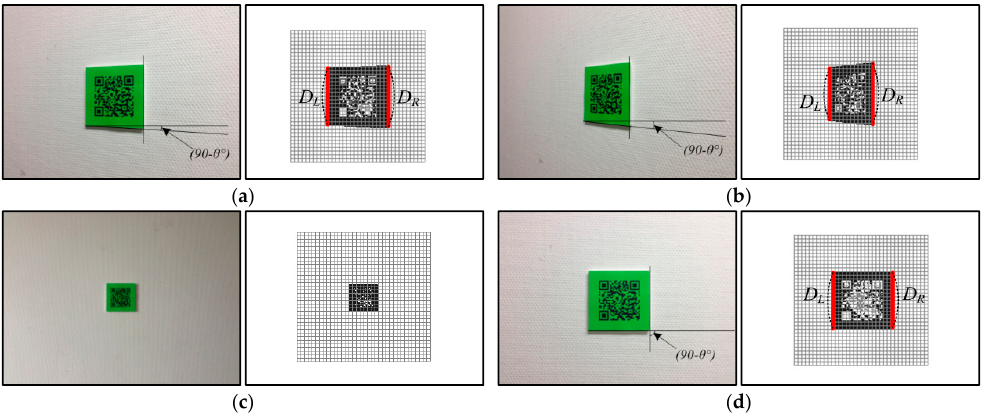
Figure 10. Process used to calculate the viewing angle from the camera to the color codes and the distance between them: ( a ) and ( b ) are images captured with the viewing angles of 20° and 50° at the distance of 0.5 m, respectively; ( c ) and ( d ) are images captured from the distance of 1.25 m and 0.5 m at the viewing angle of 0°, respectively.